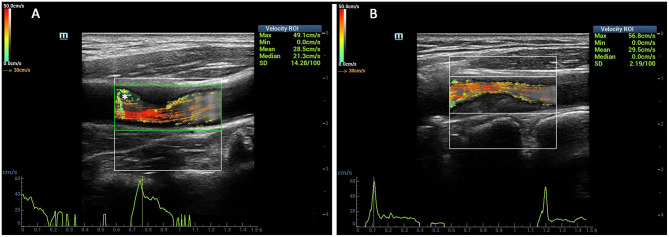
Comparison of the vector arrows between stenotic segment and normal carotid artery. The red vectors mean the high velocities, yellow and orange vectors mean medium velocities, and green vectors mean low velocities. The vector arrows in the carotid artery lumen changed from yellow to red color at the stenotic segment (A,B). The complex flow was detected at the distal of the stenosis (asterisk) (A).